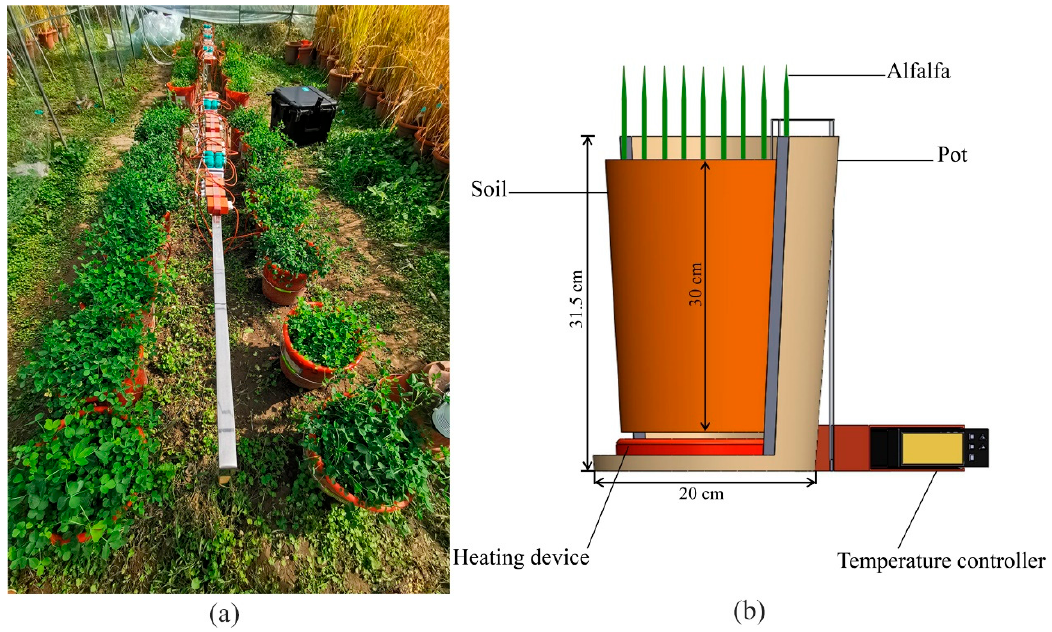
Figure 1. ( a ) Field of simulation experiment of heat stress in alfalfa and ( b ) schematic diagram of the heating equipment.